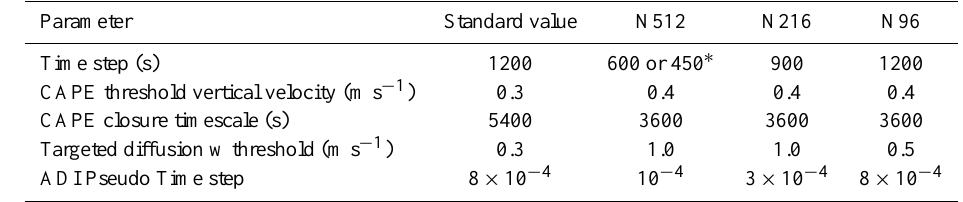
Fig. 2. Time-series of global ocean mean JJA surface temperatures for the AMIP-II (dot-dashed green line), Reynolds (dashed red line) and OSTIA (solid blue line) datasets. Table 2. Parameter differences between the GA3 standard and the configurations used here.